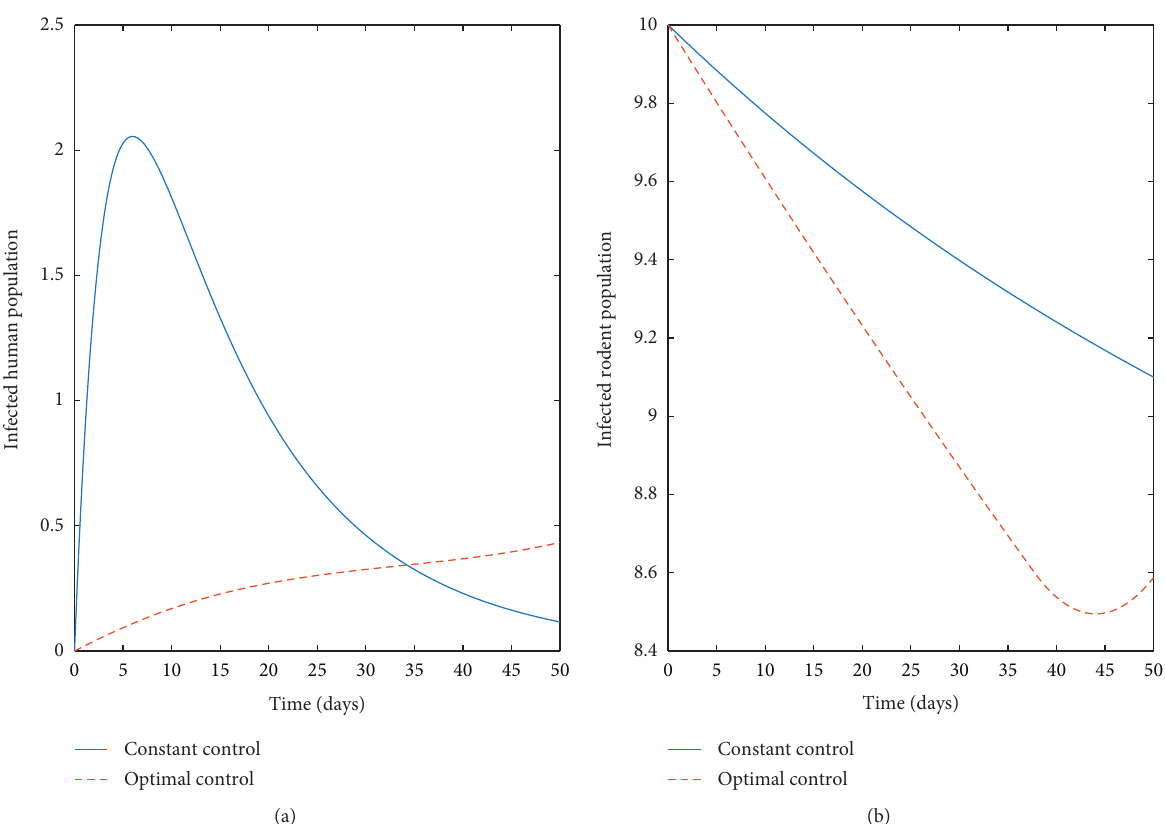
Figure 5: Graphs showing the relationship that exists between the state variables of our model: with constant control and optimal control at short